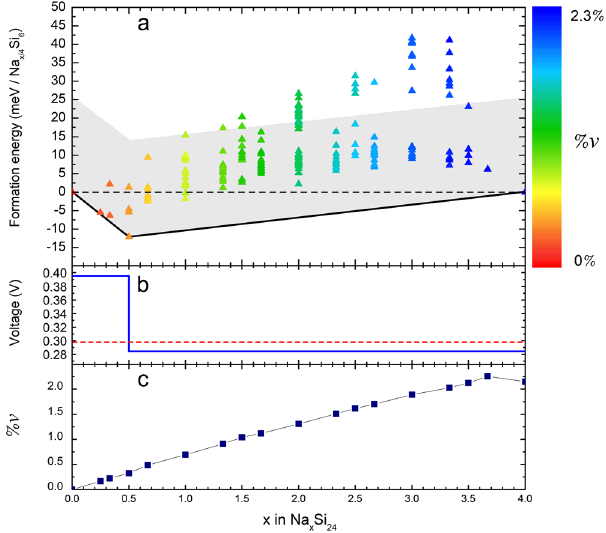
Figure 2. ( a ) Calculated formation energies as a function of sodium content in Na x Si 24 structures with different Na-  arrangements. The grey shaded area indicates formation energies within 25.6 meV ( kT at 25 °C) above the hull line. ( b ) Computed zero-temperature voltage curve (solid blue line) and average cell voltage (dashed red line). ( c ) Calculated volume change (% v ) for each Na x Si 24 ground state structure as a function of sodium content. The colour gradient scale in ( a ) shows the volume change for all considered